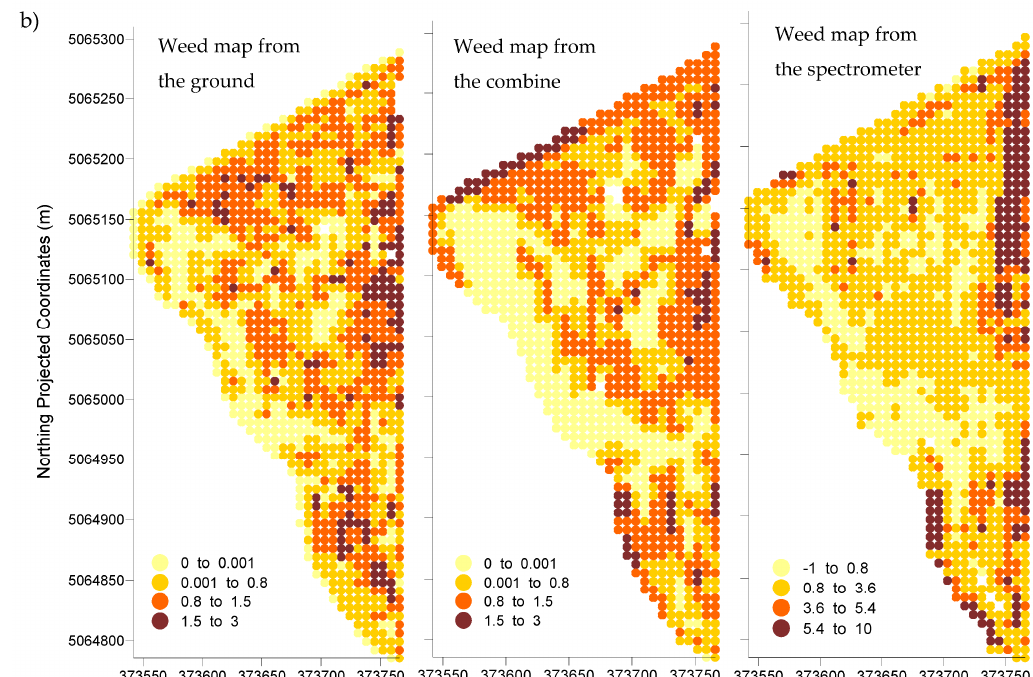
Figure 4. Infestation maps of green weeds at harvest of Field I ( a ), and Field II ( b ). Note: White areas inside the fields are missing data. The software used to build the maps was Surfer ® version 8.0.